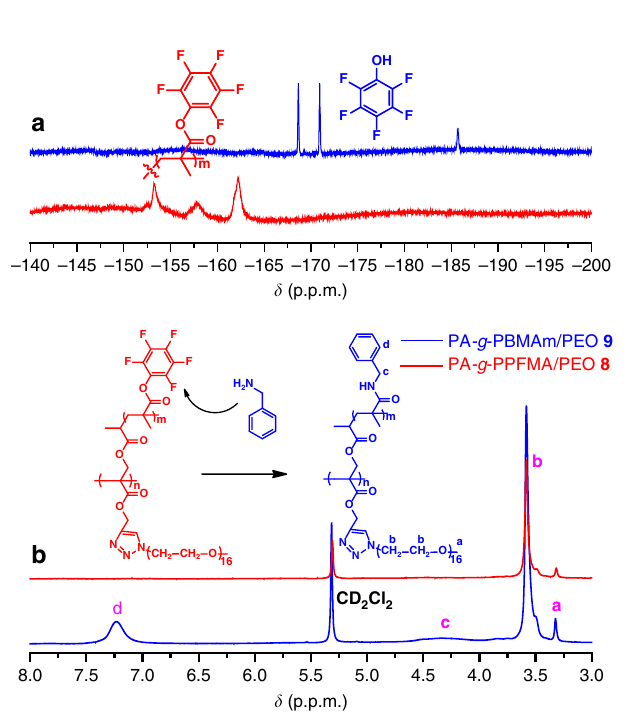
Fig. 7 Monitoring of the aminolysis reaction. 19 F ( a ) and 1 H ( b ) NMR spectra of PA- g -PPFMA/PEO 8 /benzylamine system before ( red ) and after ( blue ) the reaction in CD 2 Cl